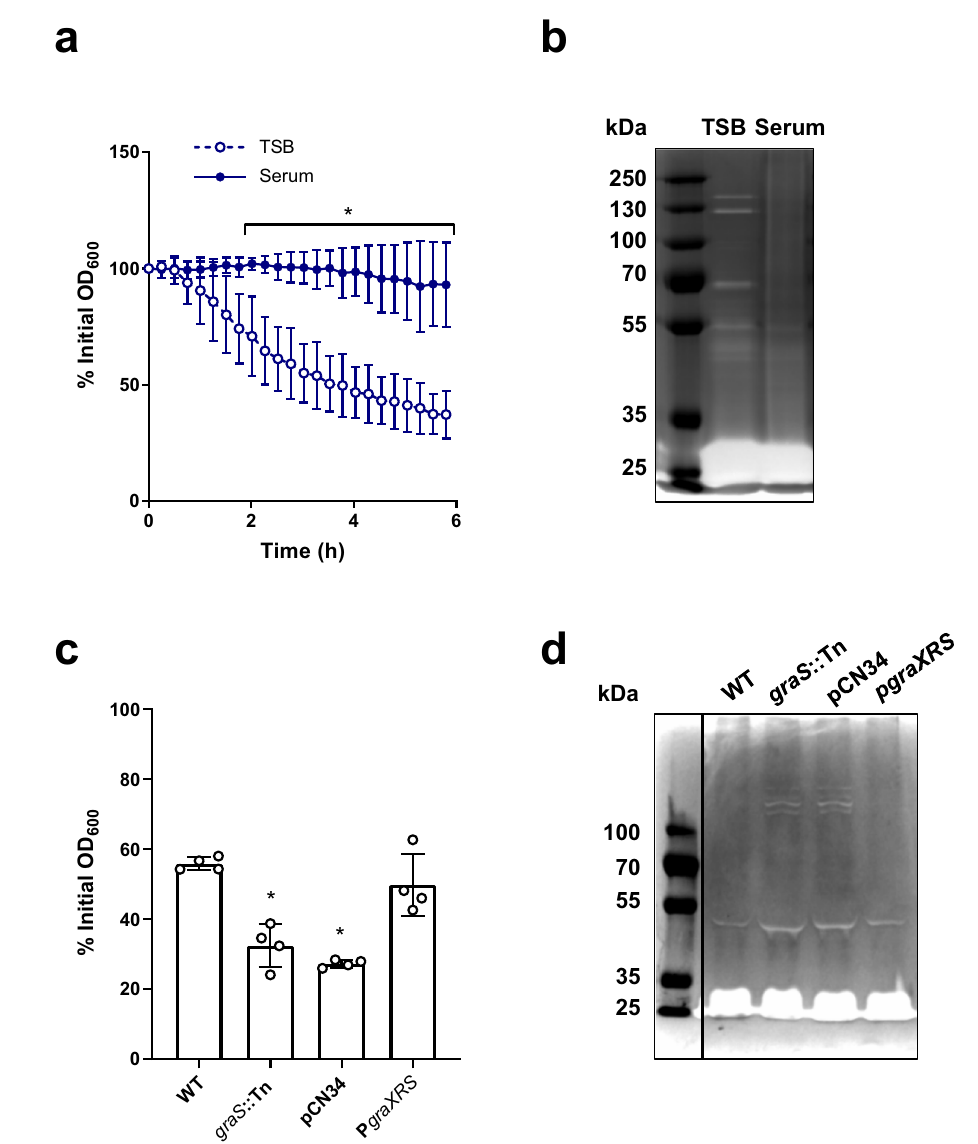
Fig. 6 Accumulation of peptidoglycan is associated with a GraRS-dependent reduction in autolysis. Triton X-100-triggered lysis of TSB-grown and serum-adapted cultures of S. aureus as measured by following OD 600 values during a 6 h exposure to 0.05% Triton X-100 ( a ). Cell wall extracts of TSB- grown and serum-adapted S. aureus were separated by SDS-PAGE using gels containing heat-killed S. aureus cells. Hydrolases were allowed to refold and zones of peptidoglycan degradation were visualised using methylene blue ( b ). Triton X-100-triggered lysis of serum-adapted cultures of S. aureus WT, the graS ::Tn mutant, and the graS ::Tn mutant complemented with empty pCN34 or P graXRS as measured by OD 600 values after a 6 h exposure to 0.05% Triton X-100 ( c ). Cell wall extracts of serum-adapted cultures of S. aureus WT, the graS ::Tn mutant, and the graS ::Tn mutant complemented with empty pCN34 or P graXRS were analysed by zymography ( d ). Graphs in ( a ) and ( c ) represent the mean ± standard deviation of three or four independent experiments, respectively. Three independent replicates of zymography were carried out and one representative image is shown. Data in ( a ) were analysed by two-way ANOVA with Sidak ’ s post-hoc test; *, P = 0.0267 (120 min), 0.0031 (135 min), 0.0011 (150 min), 0.0005 (165 min) and <0.0001 at all time- points from 180 min onwards. Data in ( c ) were analysed by one-way ANOVA with Dunnett ’ s post-hoc test; WT vs mutants (* P = 0.0002 ( graS ::Tn), <0.0001 (pCN34)). TSB, tryptic soy broth; OD 600 , optical density at 600 nm. Source data are provided as a Source Data fi